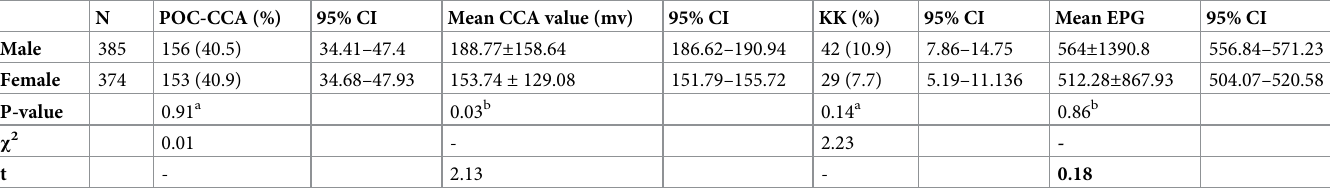
Table 2. Prevalence and intensity of S . mansoni infections by KK and POC-CCA in boys and girls.